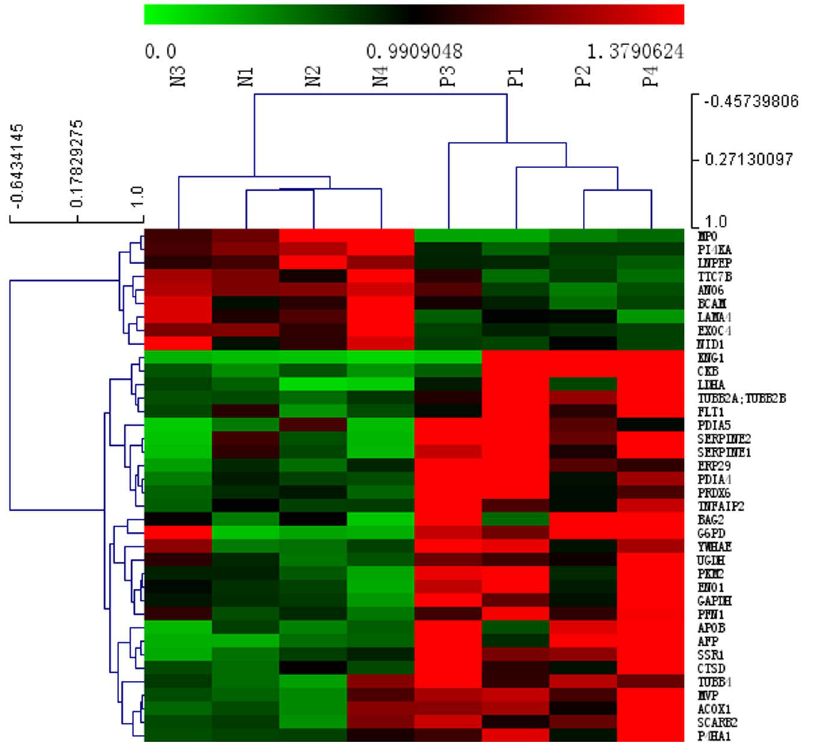
Figure 1. Cluster analysis of differentially expressed proteins in the placental tissue from pregnant women with ICP and healthy pregnant women. Hierarchical cluster analysis for the 38 differentially expressed proteins displaying significantly altered expression levels in the placental tissue from pregnant women with ICP and healthy pregnant women. ‘‘N’’ represents healthy pregnant women and ‘‘P’’ represents pregnant women with ICP. The protein expression levels are shown as colored boxes; red indicates a high expression level and green indicates a low expression level.